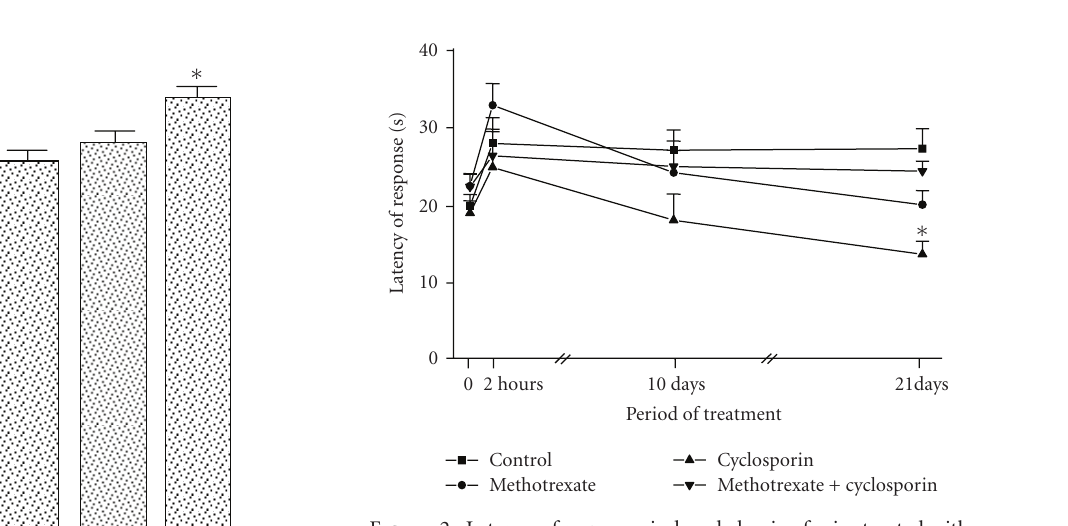
Figure 2: Latency of response-induced algesia of mice treated with methotrexate (MTX) and/or cyclosporine (CsA), or with ricine oil plus saline (control). Values are means ± SEM from 10–14 animals. ∗ P < . 001 in comparison to control (unpaired two-sided Student’s t